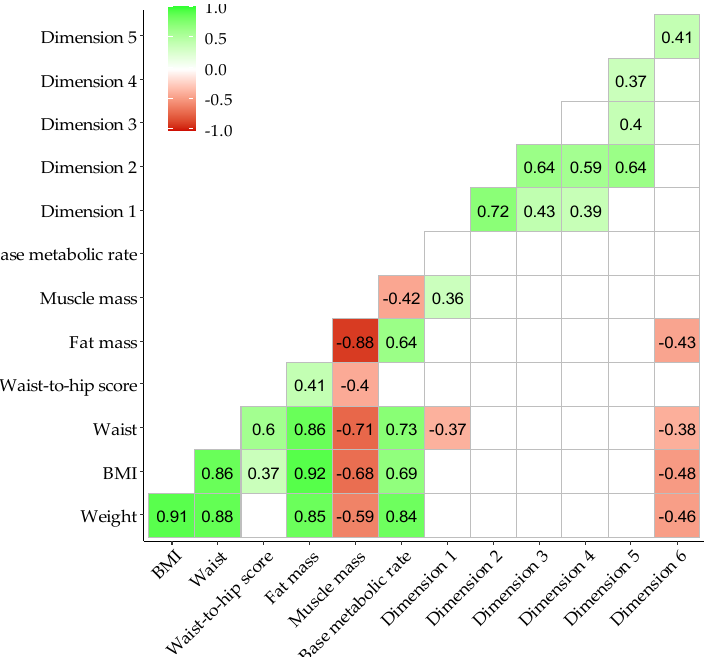
Figure 2. Correlogram between maternal body composition and dietary pattern dimensions ordered by hierarchical cluster. Body mass index (BMI). The legend represents Spearman’s rho coefficient with p -value ≤ 0.05. White grid were coefficients with p -value > 0.05.